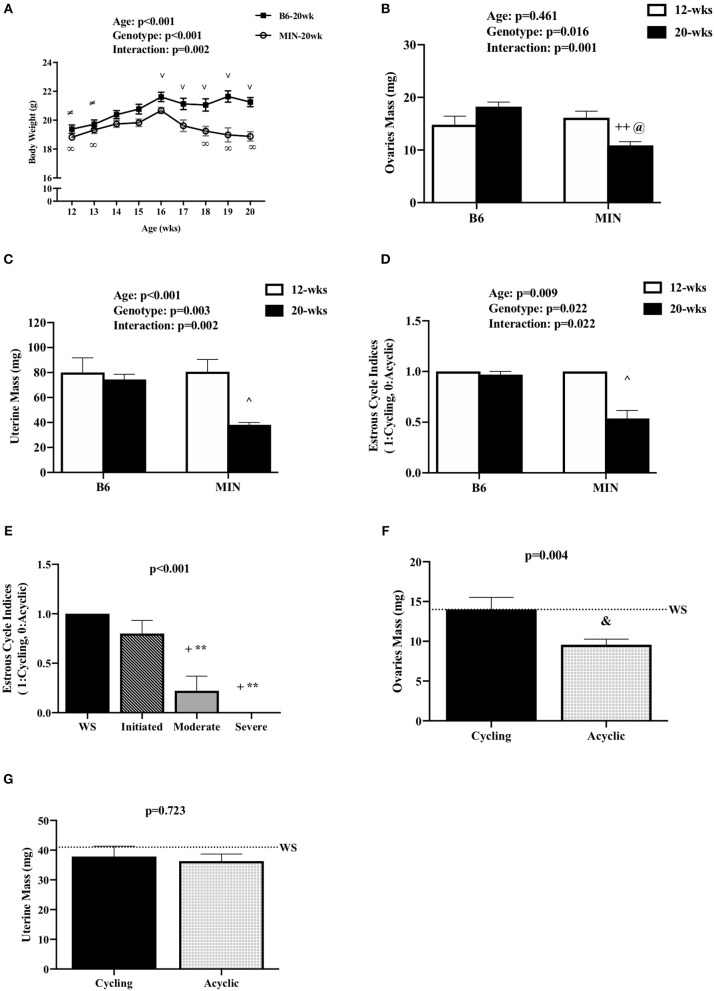
Effect of Cachexia Progression on Hypogonadism. Data is expressed as mean (standard error of the measurement). (A) Body weight from 12 to 20 weeks of age in female MIN mice. (B) Ovaries mass in 12-week and 20-week B6 and MIN mice. (C) Uterine mass in 12-week and 20-week B6 and MIN mice. (D) Estrous cycle index in 12-week and 20-week of age. (E) Estrous cycle indices in female MIN mice sacrificed at 20 weeks of age stratified by severity. (F) Ovaries mass in cycling and acyclic MIN mice. (G) Uterine mass in cycling and acyclic MIN mice. Dashed line is a reference point for female Weight Stable (WS) MIN mice. WS, weight stable; mg, milligrams; %, percent; mm, millimeters. Symbols for statistical significance: ∞Different than MIN at 16 weeks, ≠Different than B6 at 16 weeks, and ∨ Different than MIN at given time point, ++Different than 12 week MIN, @Different than 20 week B6, ∧Different than all groups, +Different than WS, **Different than Initiated, &Different than Cycling.